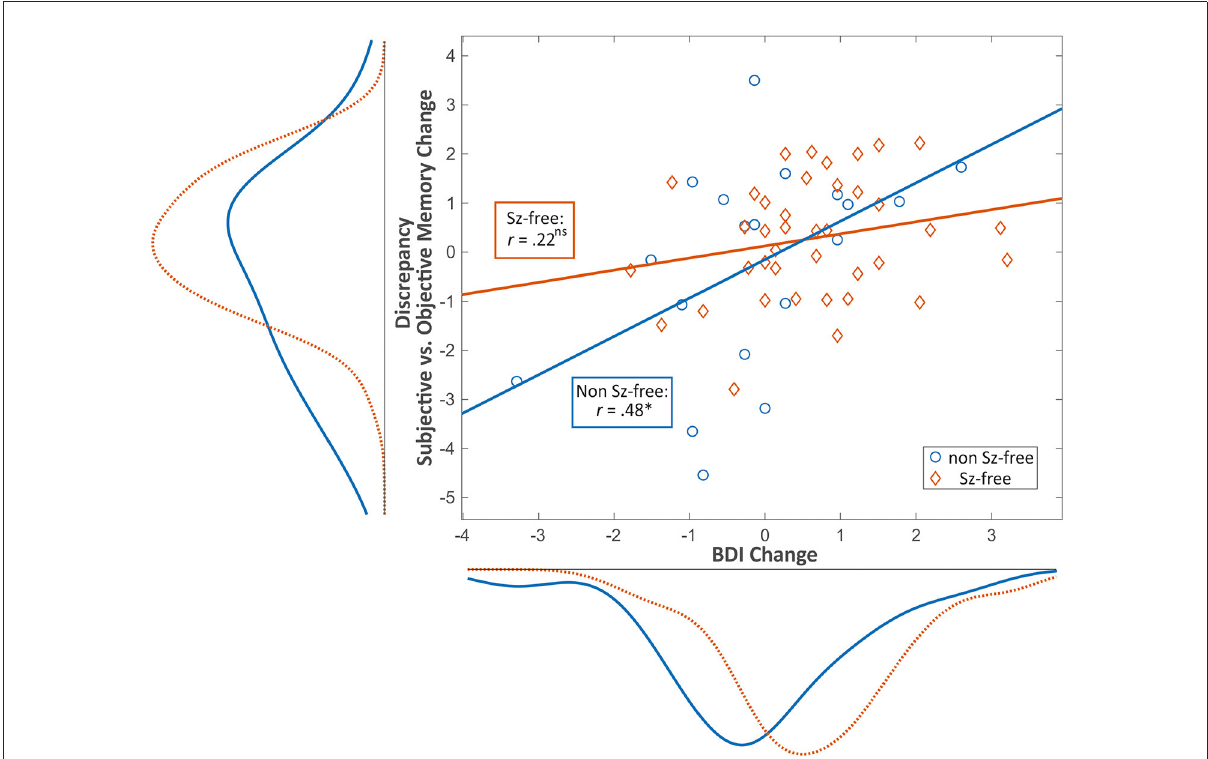
FIGURE3 Scatter plot showing the relationship between pre- to postoperative change in depressive symptoms (x) and discrepancy (i.e., over-/ underestimation) between subjective and objective memory change (y) and the respective distribution curves for seizure-free (red) vs. non-seizure-free patients (blue). Values are given in standardized z-scores. Negative values on the y-axis represent overestimation whereas positive values represent underestimation of memory decline. Values near zero represent an adequate estimation of memory change. Positive values on the x-axis represent a postoperative decrease of depressive mood. * p < 0.05; ns, non-significant; Sz, seizure; BDI, Beck Depression Inventory.